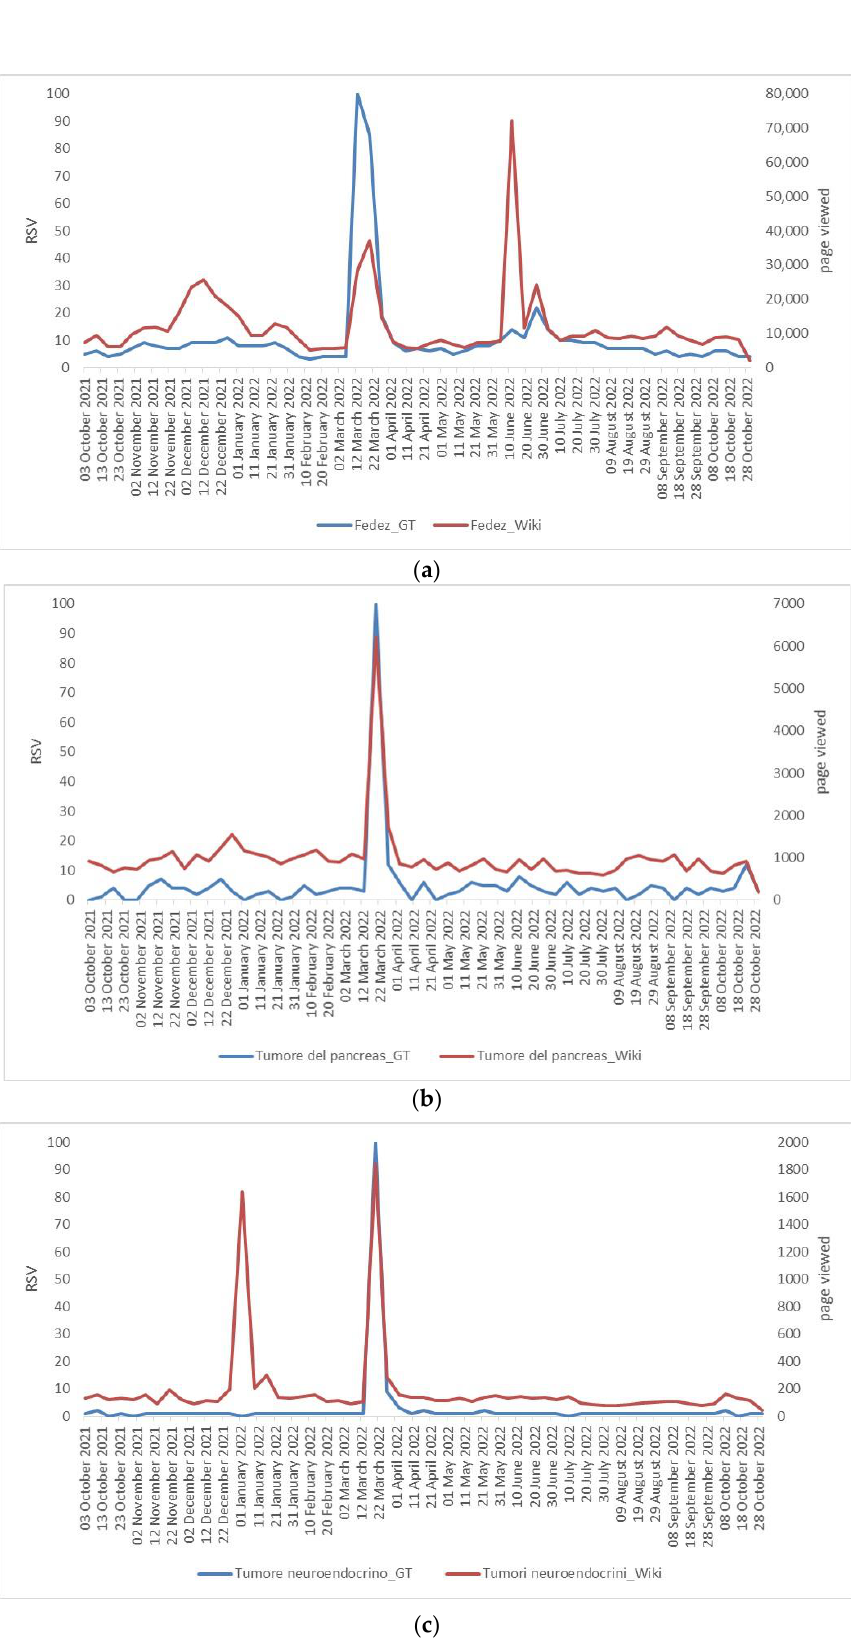
Figure 1. Comparison of Google Trends and Wikipedia search term curves: ( a ) comparing the word Fedez; ( b ) pancreatic cancer — Tumore del pancreas in Italian; ( c ) neuroendocrine cancer — Tumore neuroendocrino in Italian. Period analyzed from 3 October 2021 to 30 October 2022; data were aggregated